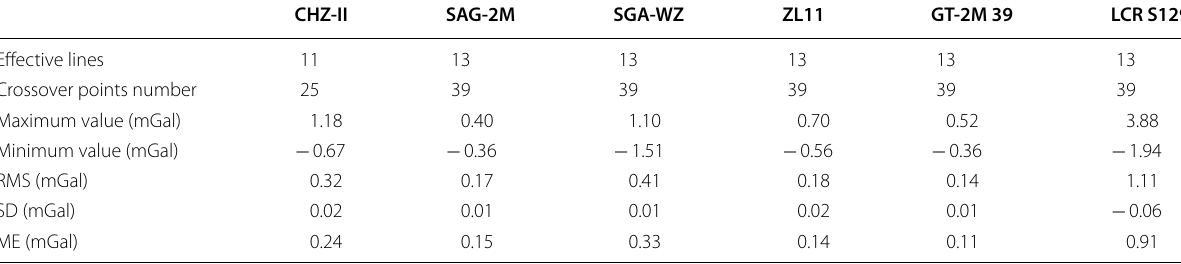
Table 5 Crossover points error statistics for the different